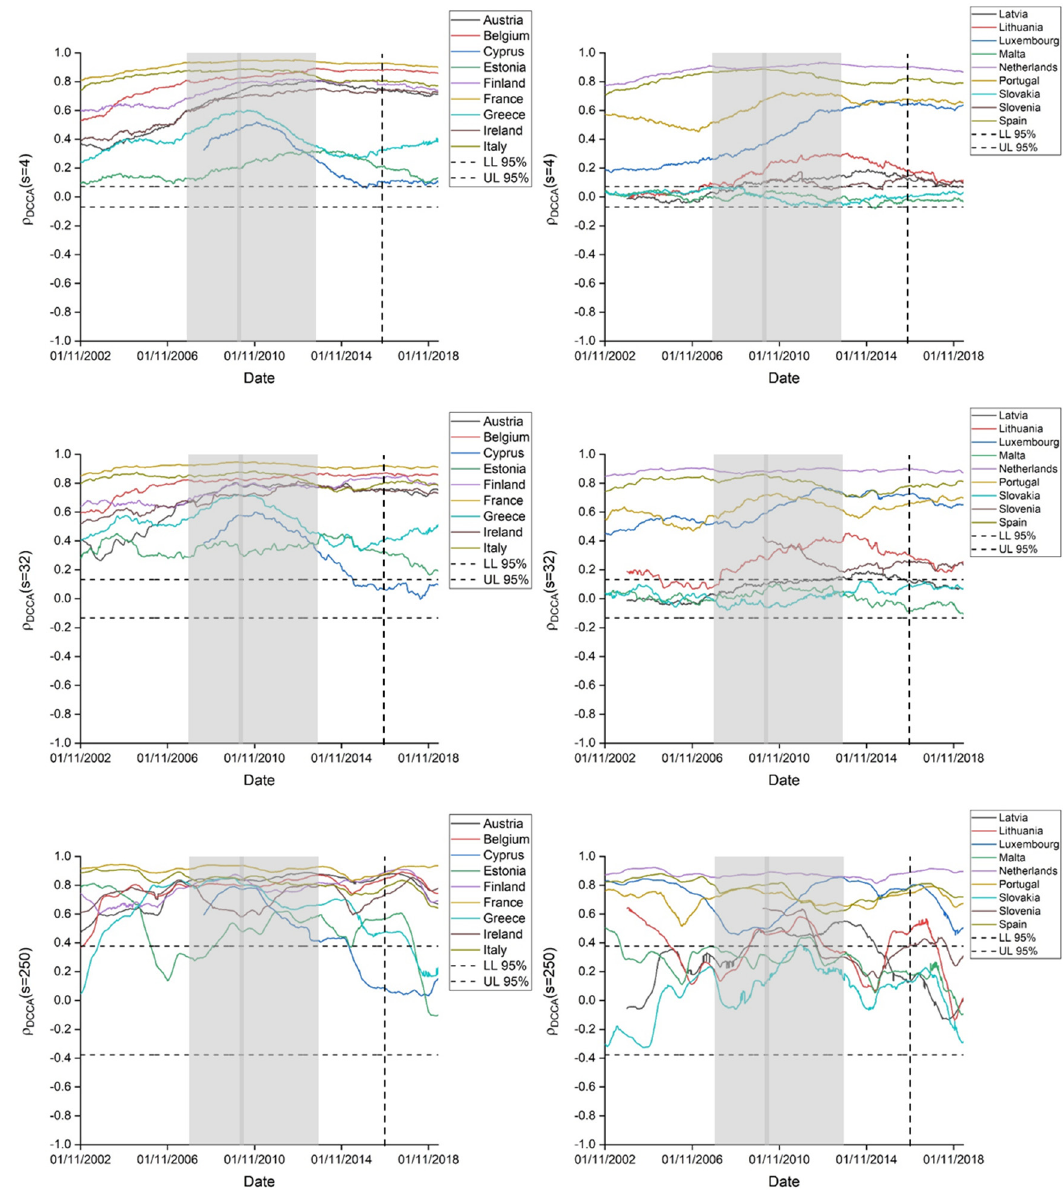
Figure 1. Evolution of the correlation coe ffi cient of the detrended cross-correlation analysis ( ρ DCCA ) between Eurozone stock markets and Germany (time scales of 4, 32, and 250 days and window size w = 1000). LL and UL are, respectively, the lower and upper limits of the confidence interval. Shaded areas represent the global financial crisis and the Eurozone debt crisis. The vertical dashed line refers to the moment of the Brexit referendum.